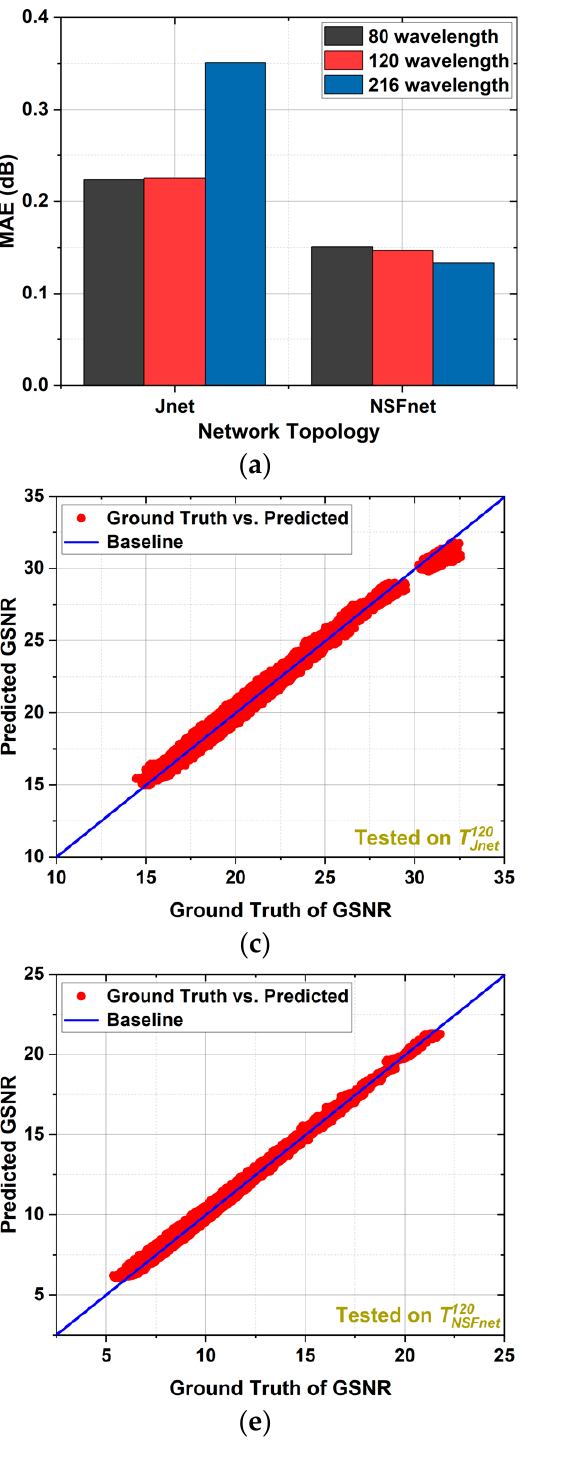
Figure 7. Estimation accuracy of the SA-QoT-E in the Jnet and NSFnet with different numbers of wavelengths: ( a ) testing MAE of the SA-QoT-E in the Jnet and NSFnet; ( b ) testing R2 of the SA-QoT-E in the Jnet and NSFnet; ( c ) ground truth of GSNR vs. predicted GSNR based on the SA-QoT-E in the Jnet with 120 wavelengths; ( d ) ground truth of GSNR vs. predicted GSNR based on the SA-QoT-E in the Jnet with 216 wavelengths; ( e ) ground truth of GSNR vs. predicted GSNR based on the SA-QoT-E in the NSFnet with 120 wavelengths; ( f ) ground truth of GSNR vs. predicted GSNR based on the SA-QoT-E in the NSFnet with 216 wavelengths.